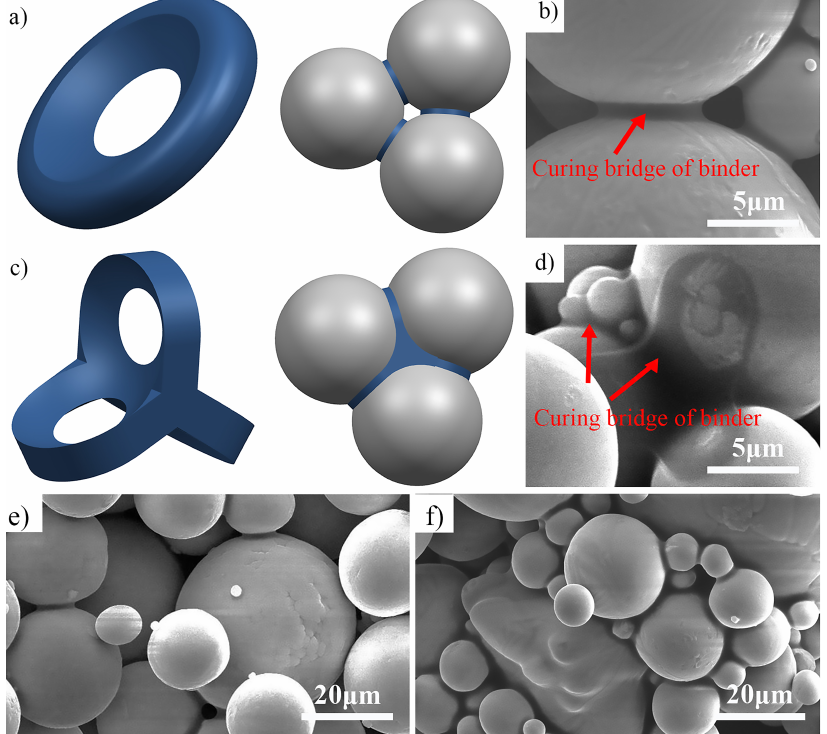
Figure 5. The establishment of the theoretical model and the characterization of the SEM to assist in understanding BJ3DP. A model for the single structure of the curing bridge ( a ) and SEM of sample ( b ); a model for the staggered structure of the curing bridge ( c ) and SEM of sample ( d ); SEM of the sample with pure powder ( e ) and mixed powder ( f ).